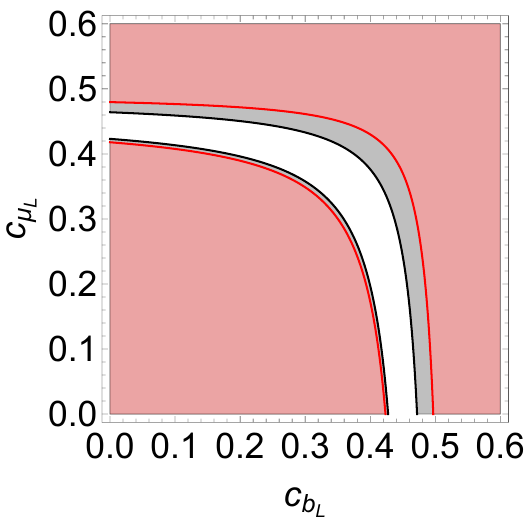
Figure 7 . Region in the ( c b from the (cid:12)t of ref. [70] (blank region inside gray bands). We overlap as well the allowed region coming from the R K anomaly (blank region inside red